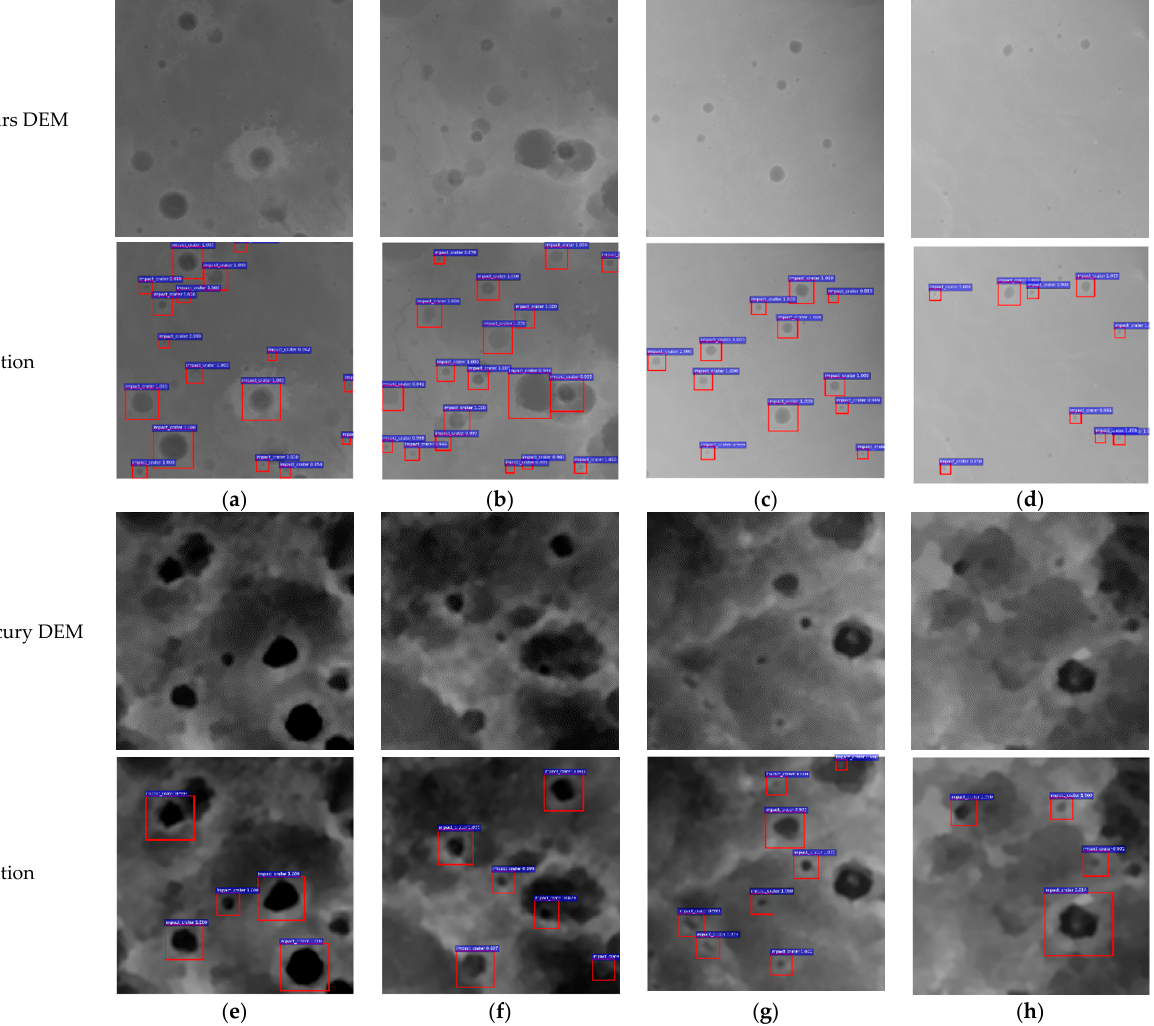
Figure 14. Transfer learning to Mars and Mercury impact craters. Mars crater detection results ( a – d ), and Mercury crater detection results ( e – h ).